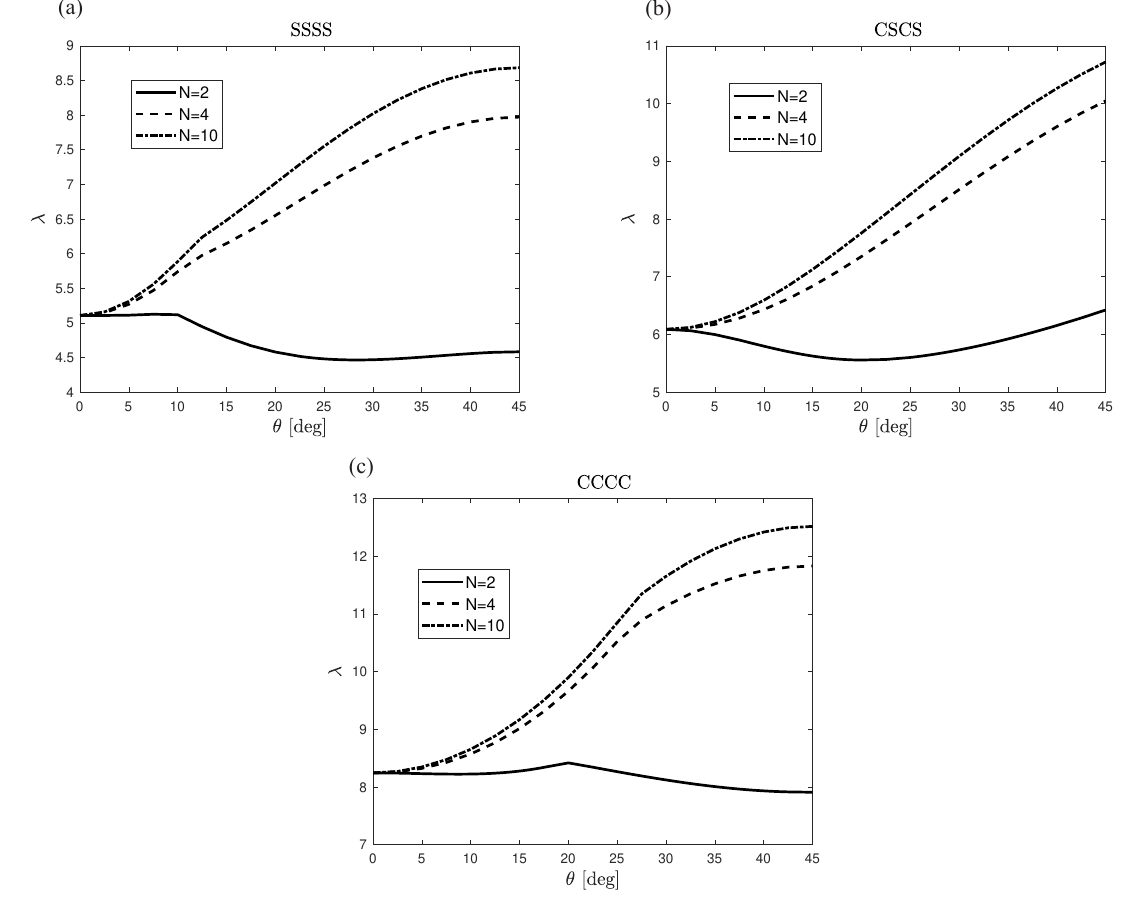
Fig. 3. Biaxial buckling parameters for L2 squared plates.